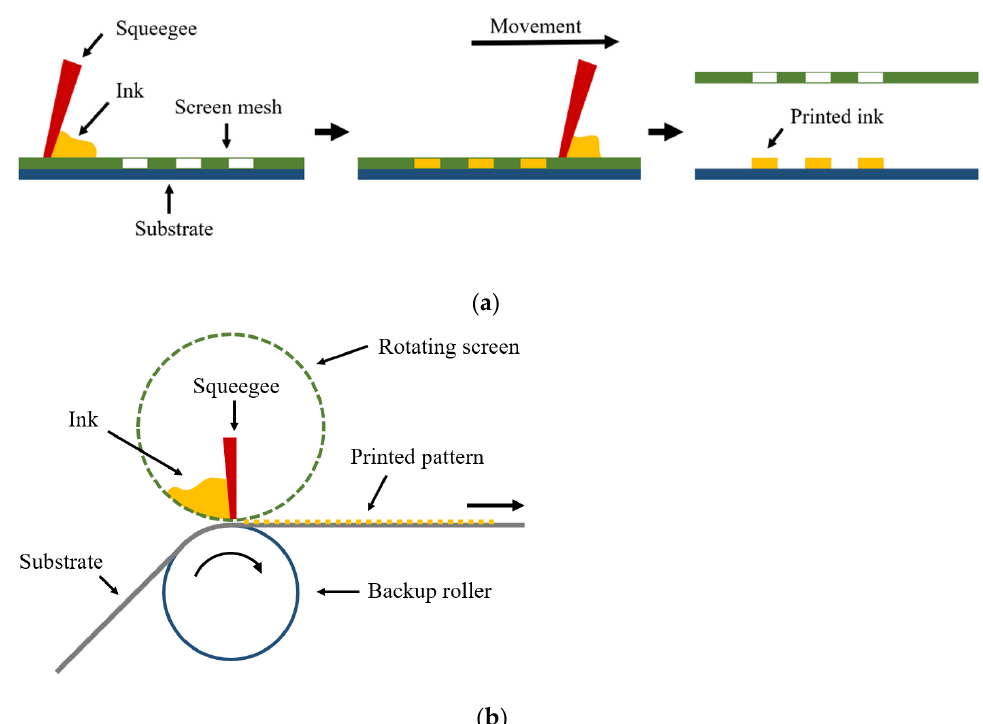
Figure 3. ( a ) Illustration of the screen-printing process [55]. ( b ) Schematic drawing of the roll-to-roll (R2R) screen printing process [62].